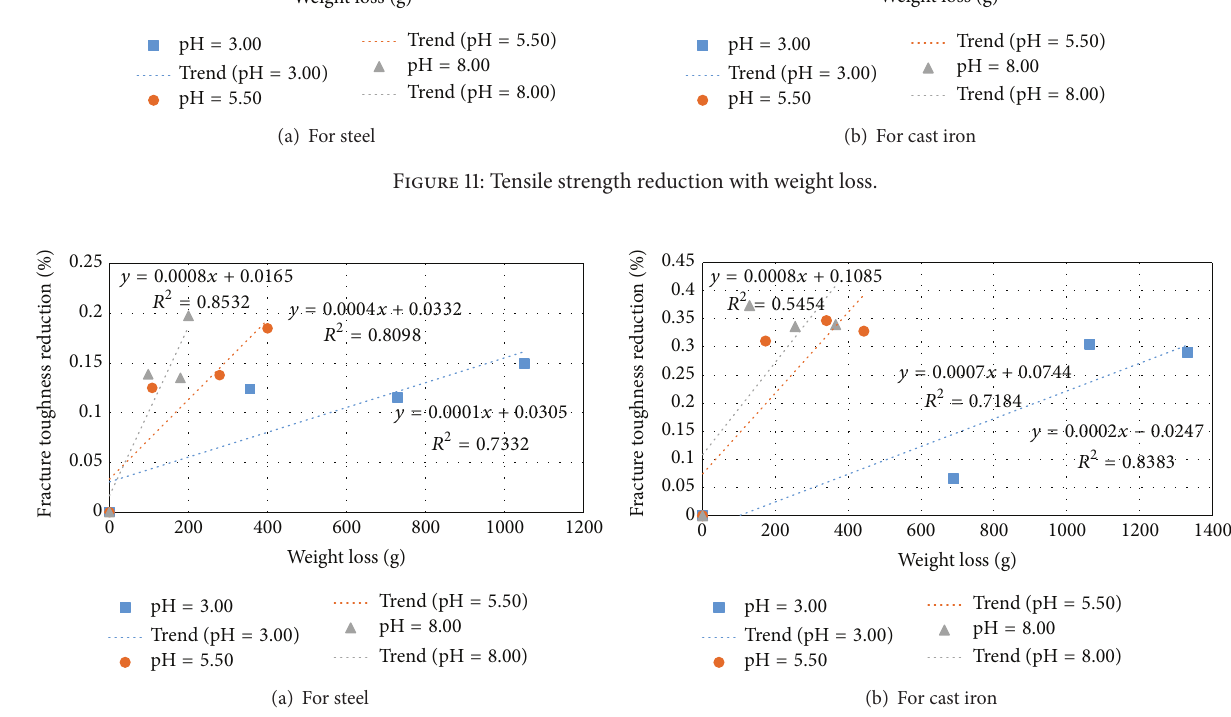
Figure 12: Fracture toughness reduction with weight